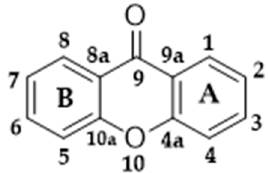
Figure 4. Basic structure of xanthones.